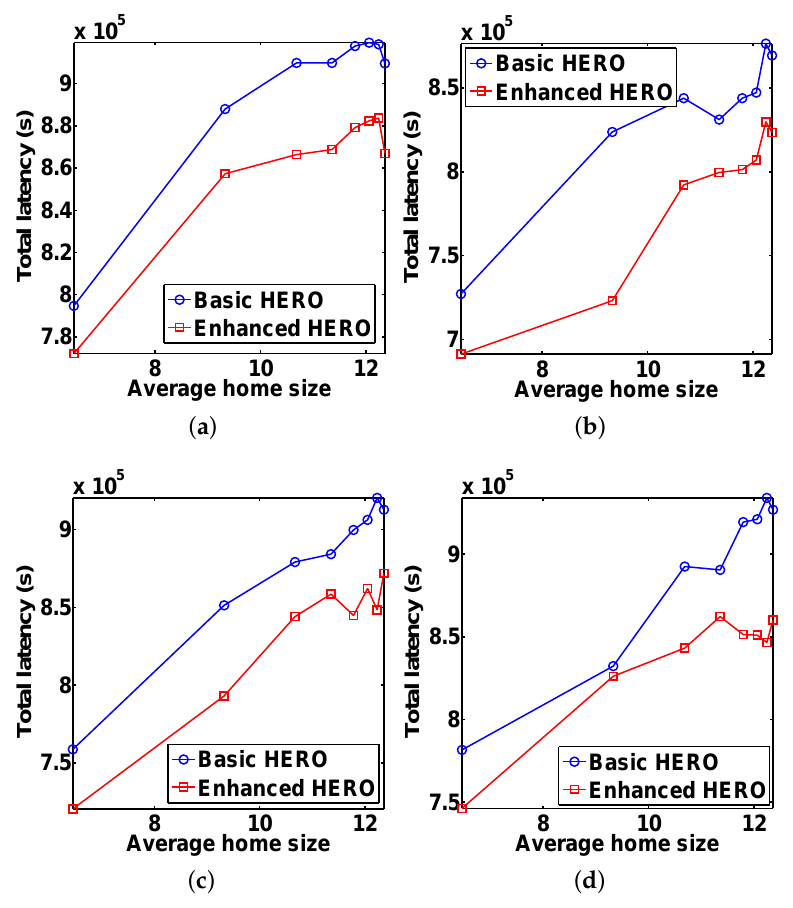
Figure 8. The impact of home size on the average total latency, which shows that the total latencies of enhanced HERO are better than those of basic HERO in all scenarios. ( a ) U = 300; ( b ) U = 400; ( c ) U = 500; ( d ) U =